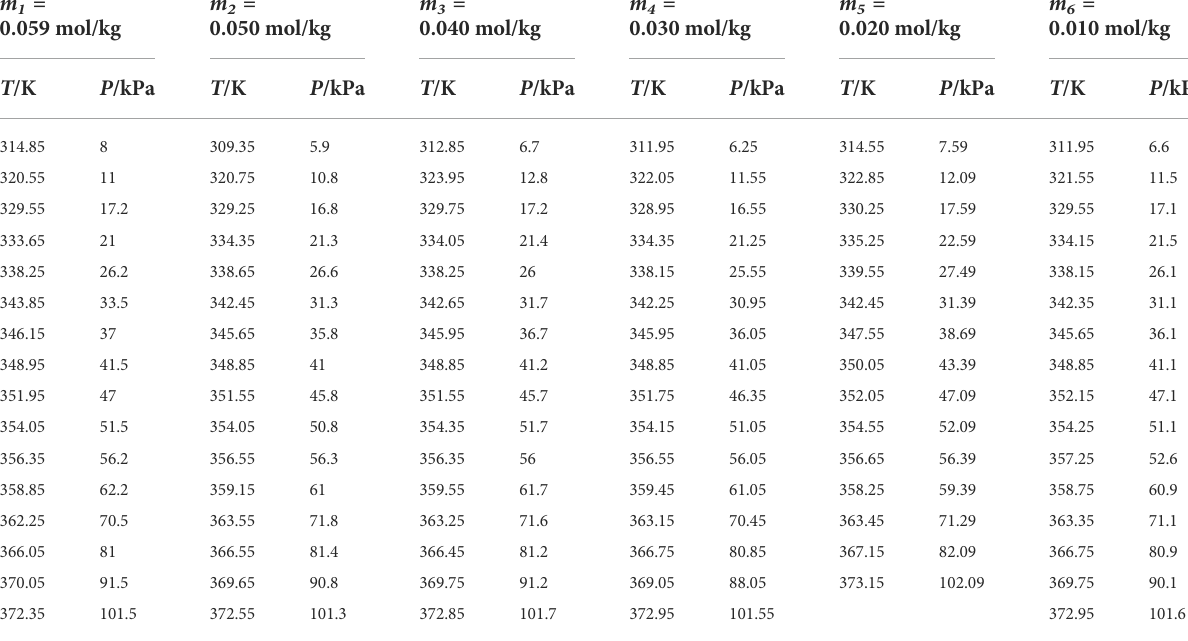
TABLE 4 Experimental VLE data for temperature T , pressure P , and molality m for the L -glutamic acid + H 2 O system a